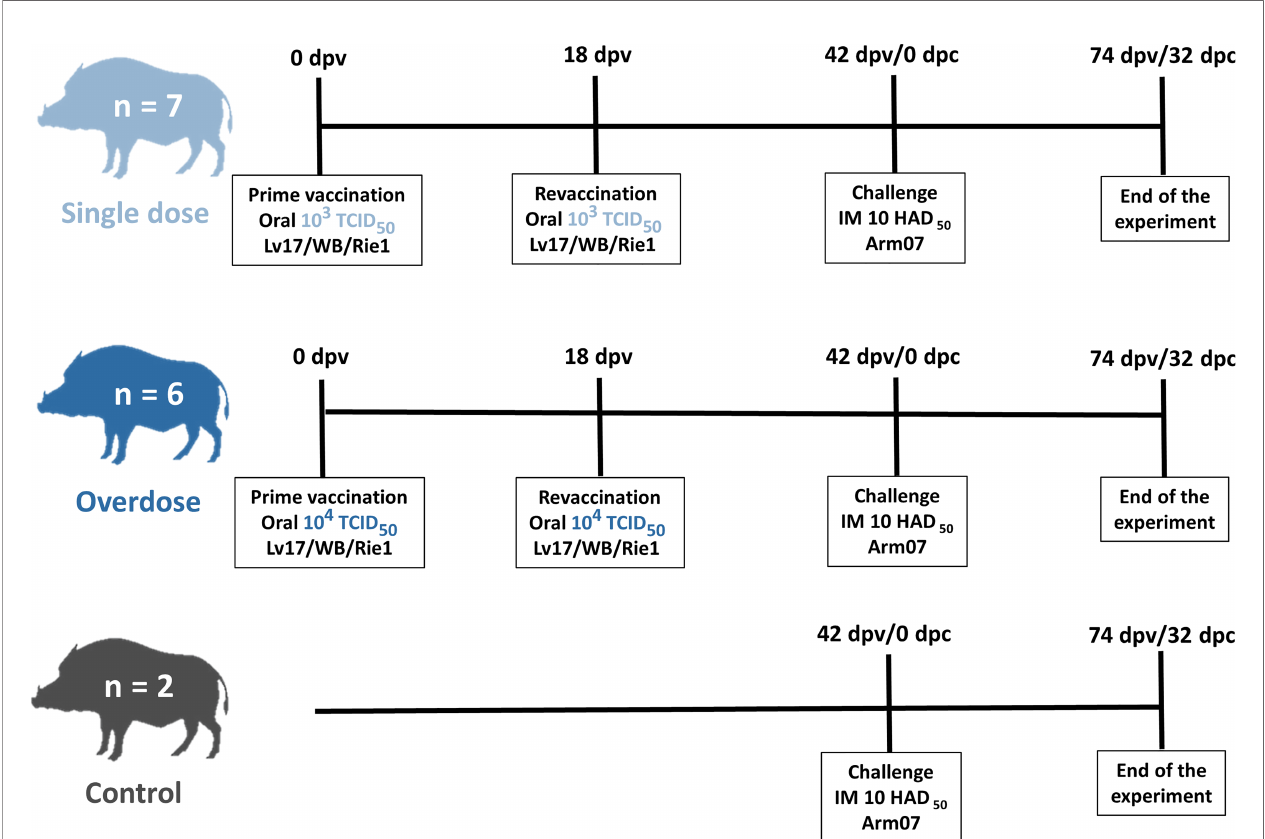
FIGURE 1 | Scheme of the experimental design from the prime vaccination (0 days post-vaccination, dpv) until the end of the experiment (32 days post-challenge, dpc; and 74